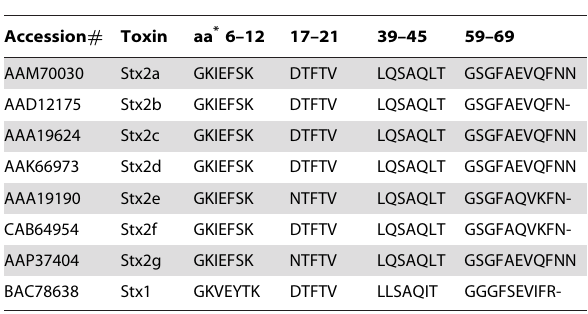
Table 5. Stx2 polyclonal antisera binding to consensus epitopes of B-subunit determined using overlapping Stx2a peptides.